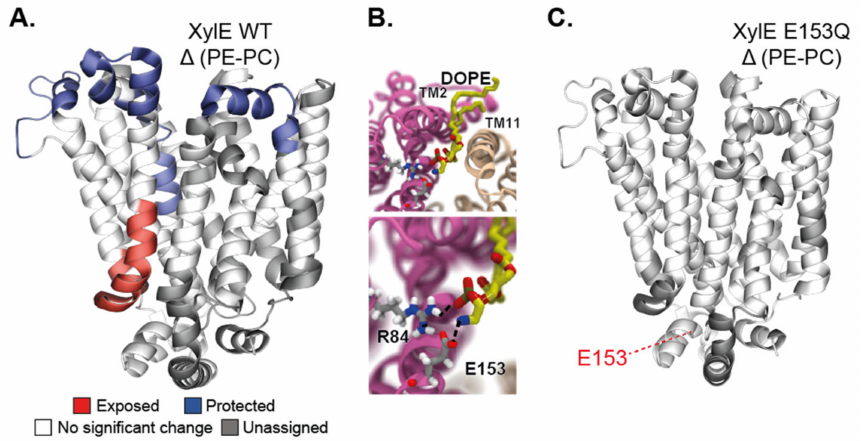
Figure 4. Lipid–protein interactions regulate the conformational equilibrium. ( A ) Differential deuterium uptake pattern ( ∆ HDX) of WT XylE in DOPE-PG-CL nanodiscs (native-like) minus DOPC- PG-CL (control) mapped onto the 3D structure of XylE (PDB: 4GBY). Red- and blue-colored regions indicate segments containing peptides with a positive ∆ HDX (red—more deuteration) or negative ∆ HDX (blue—less deuteration), respectively; white regions indicate that no significant ∆ HDX is observed ( p ≤ 0.01), and gray indicates regions where peptides were not obtained for both the mutant and the WT conditions. ( B ) Representative MD snapshot of the close-up of the conserved, charged residues interacting with the PE headgroup of the phospholipid. Polar interactions with R84 and E153 prevent network formation and steric hindrance prevents contacts of the TM2 and TM11. ( C ) Mutagenesis of E153 abolishes a lipid-induced conformational shift. ∆ HDX of XylE in PE:PG:CL nanodiscs (native-like) minus PC:PG:CL (control) nanodiscs mapped on the PDB structure. Adapted from